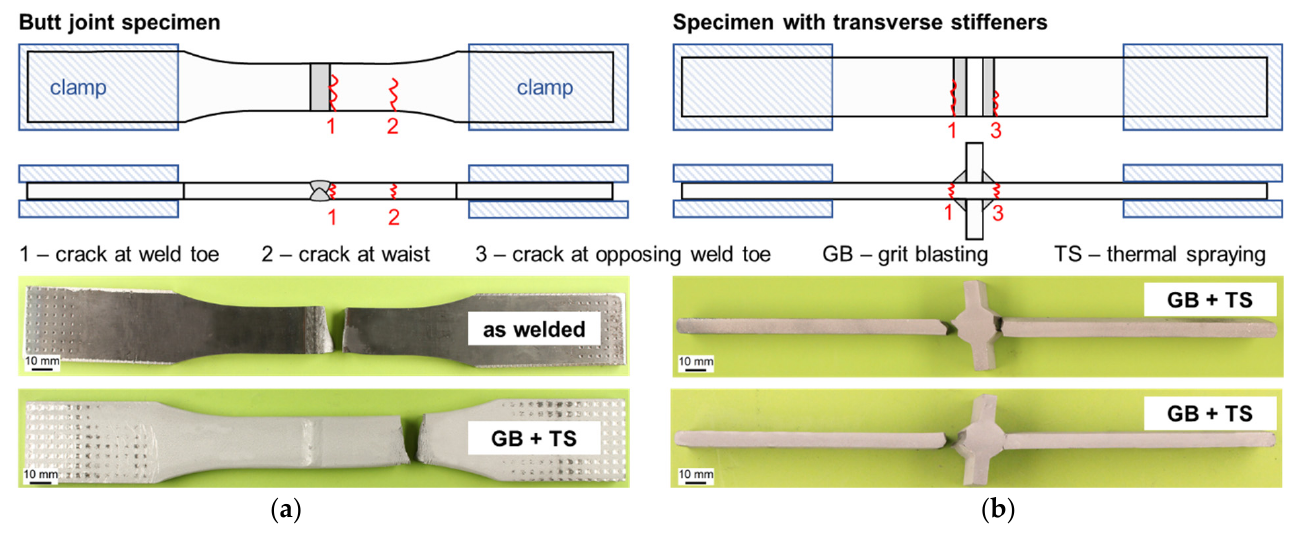
Figure 10. Failure locations. ( a ) Butt joint specimens; ( b ) Specimens with transverse stiffeners.